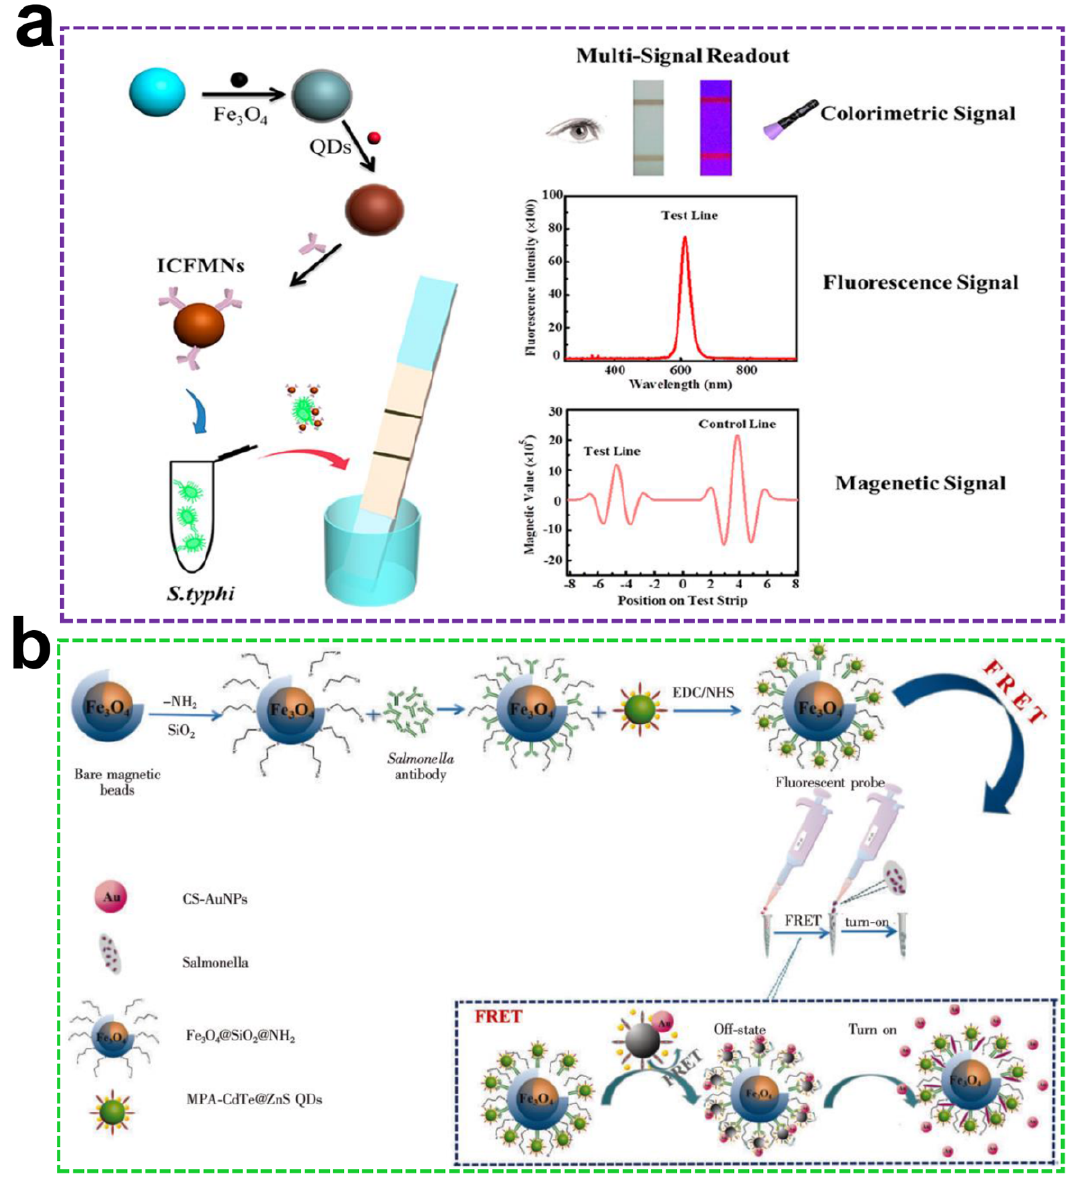
Figure 5. ( a ) Schematic diagram for triple signal output detection of S. typhi by using MNP@QDs- based-LFIA. Reproduced with permission from [140]. Copyright Analytical Chemistry, 2019; ( b ) Schematic illustration of an off-on fluorescent probe for rapid detection of S. typhi based on FRET effect. Reproduced with permission from [148]. Copyright Chinese Journal of Analytical Chemistry, 2019.